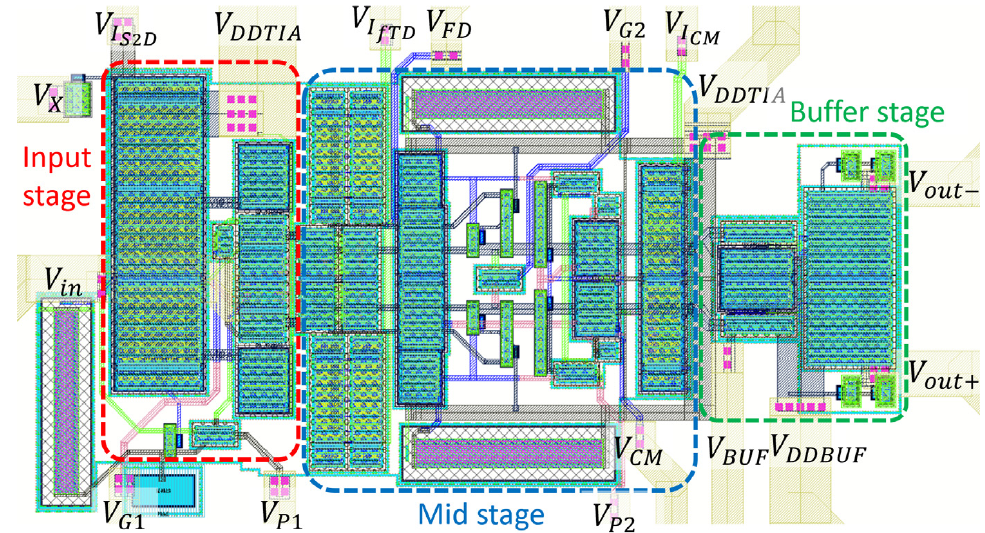
Figure 5. Layout of the TIA input, mid and buffer stages.